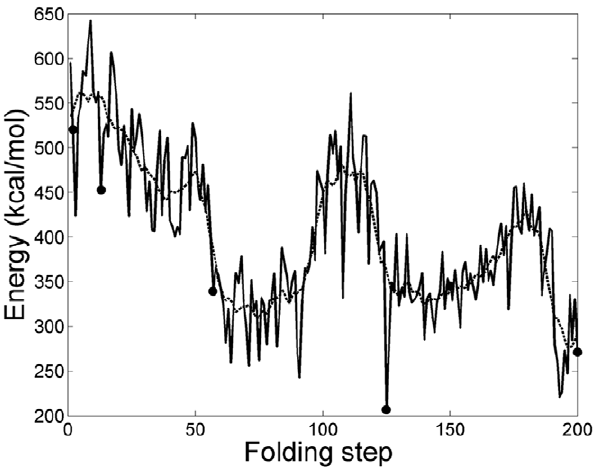
Figure 6. The internal energy of protein during its folding. The dashed curve is obtained by taking moving average of the data and it is included to mark the general trend. Circles correspond to the structures shown in Fig.